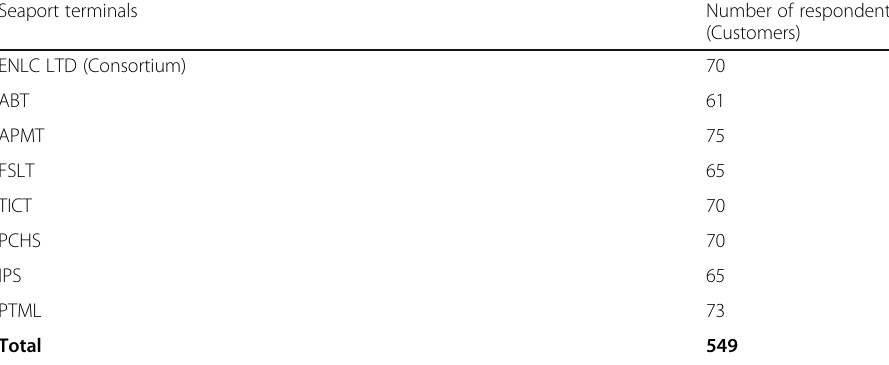
Table 1 Summary of